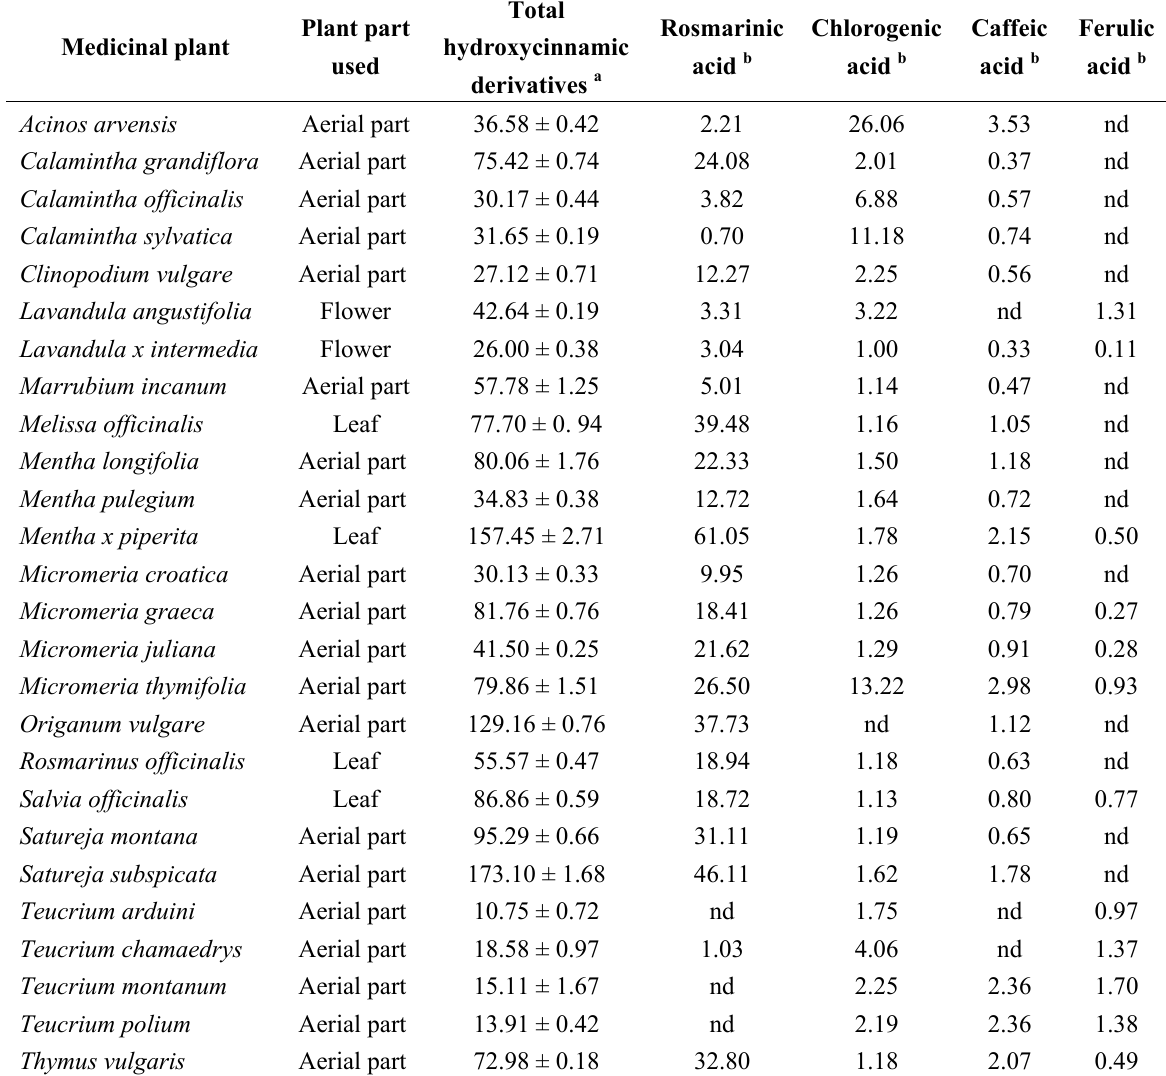
Table 2. Content and composition of hydroxycinnamic derivatives of Lamiaceae ethanolic